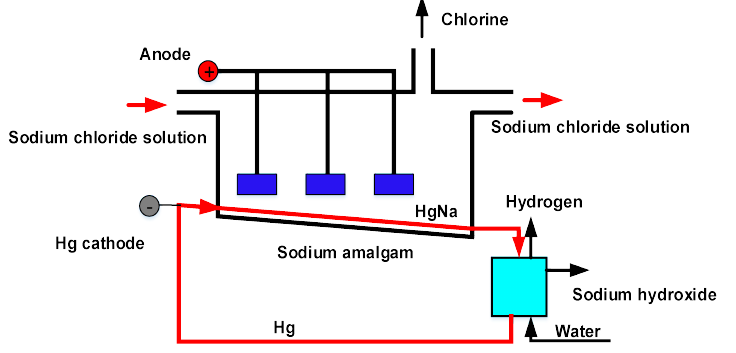
Figure 1. Mercury cell